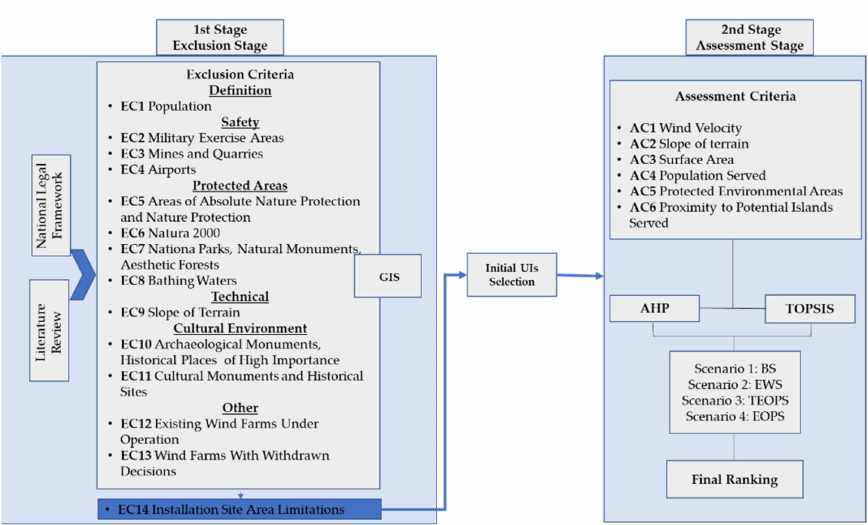
Figure 1. Methodological framework for wind farm deployment on UIs in the South Aegean region of